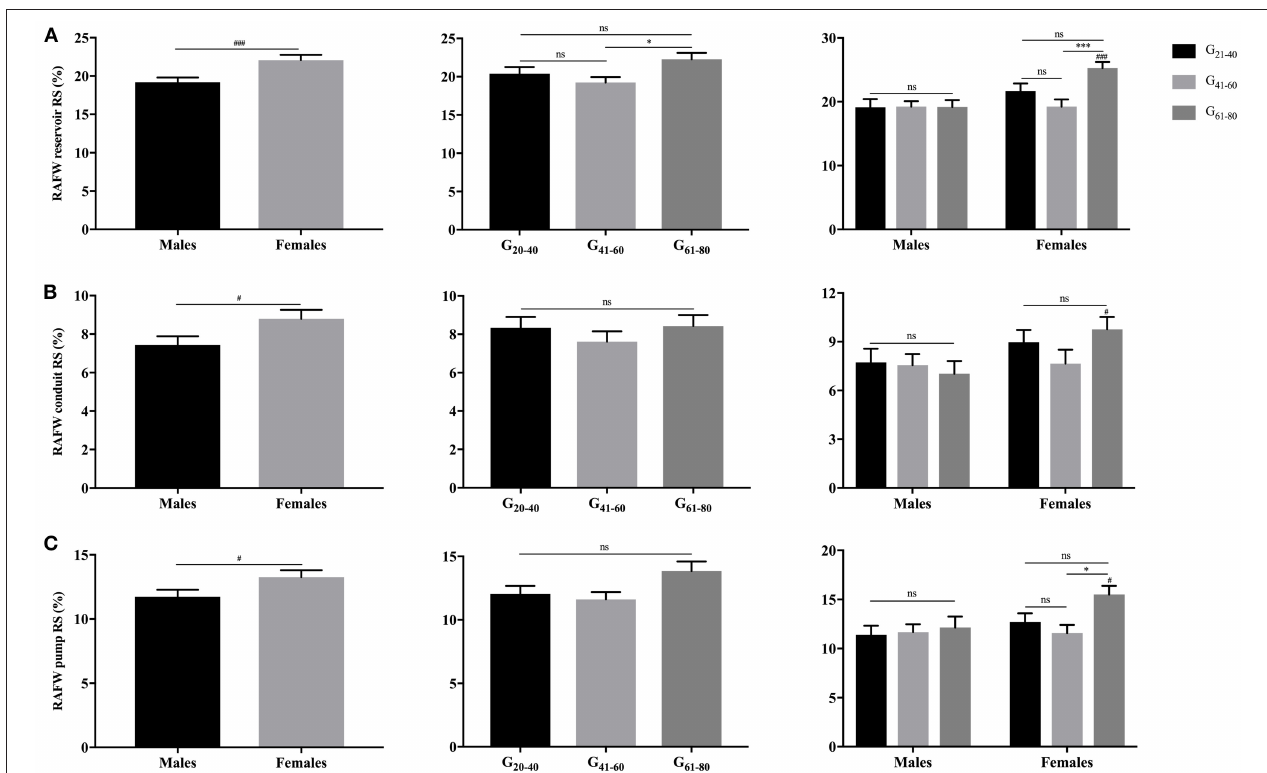
FIGURE 5 | Gender- and age-related differences of RAFW reservoir RS (A) , conduit RS (B) , and pump RS (C) . # P < 0.05, ### P < 0.001: gender-related difference; * P < 0.05, *** P < 0.001: age-related difference; ns, not